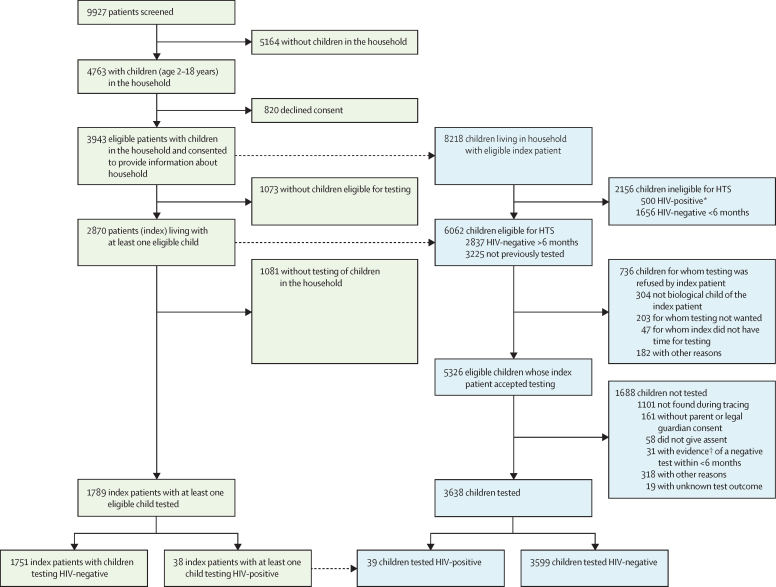
Screening and HIV testing flow for HIV-positive clinic attendees (green) and children living in their households (blue)HTS=HIV testing services. *490 children registered in care and 10 not registered in care. †Test result slip or note in the child's medical records.